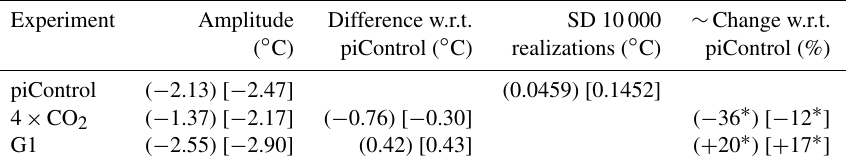
Table 4. Maximum amplitude of cold